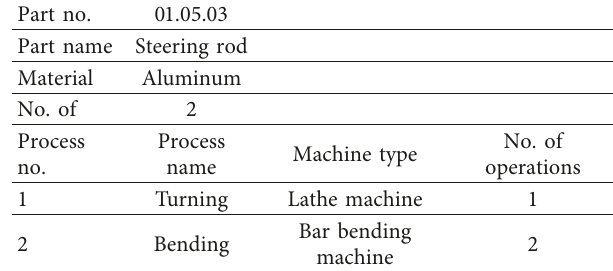
Table 11: Steering rod.